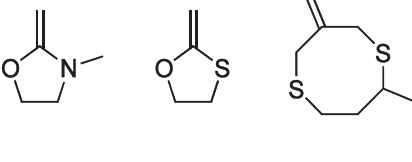
Figure 7. Some heterocyclic monomers which have been shown to undergo radical ROP [16,18,19].